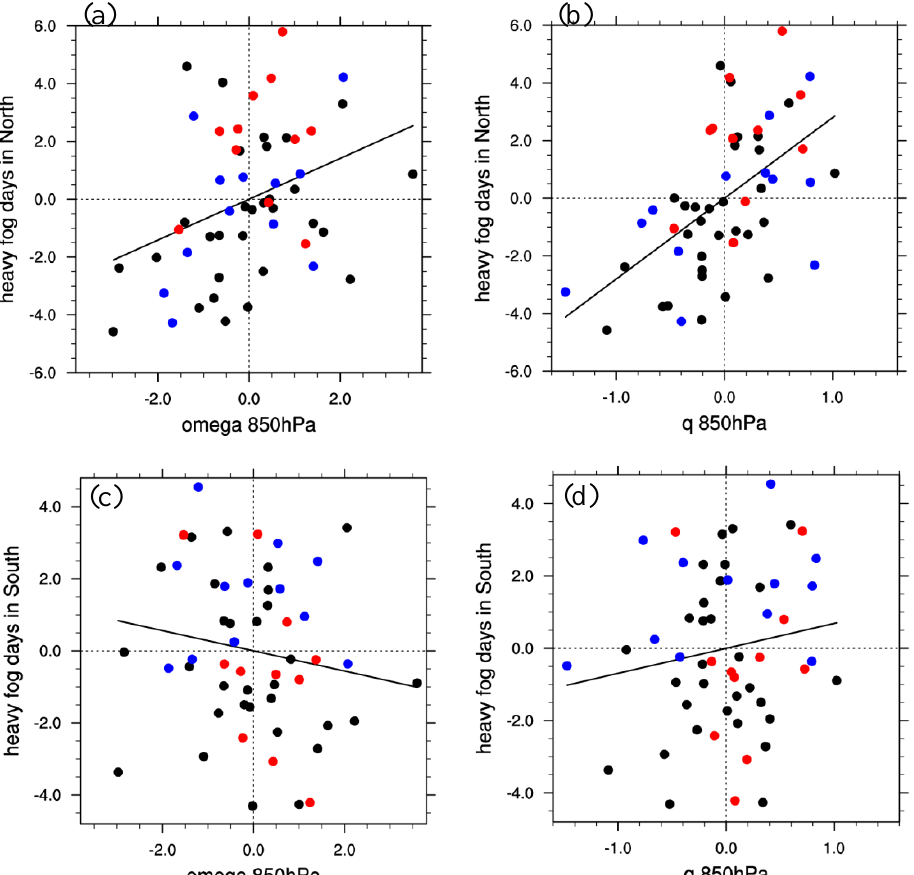
Figure 11. Scatter plots ( a ) for omega (110–120 ◦ E, 20–30 ◦ N) and heavy fog days, ( b ) for specific humidity (110–120 ◦ E, 20–30 ◦ N) and heavy fog days in North China, where the red, blue and black denote the AO positive phase, AO negative phase and near neutral states, respectively. The linear fit line is added in each panel. ( c , d ) in South China are the same as ( a , b ) except in North China (omega unit: − 0.01 Pa / s; specific humidity q unit: g / kg; heavy fog days unit: day.). Table 2. Correlation coe ffi cient of fog days in di ff erent regions with the AO index and regional meteorological fields (above 0.22 or 0.27 represents the values above the 90% or 95% confidence level,